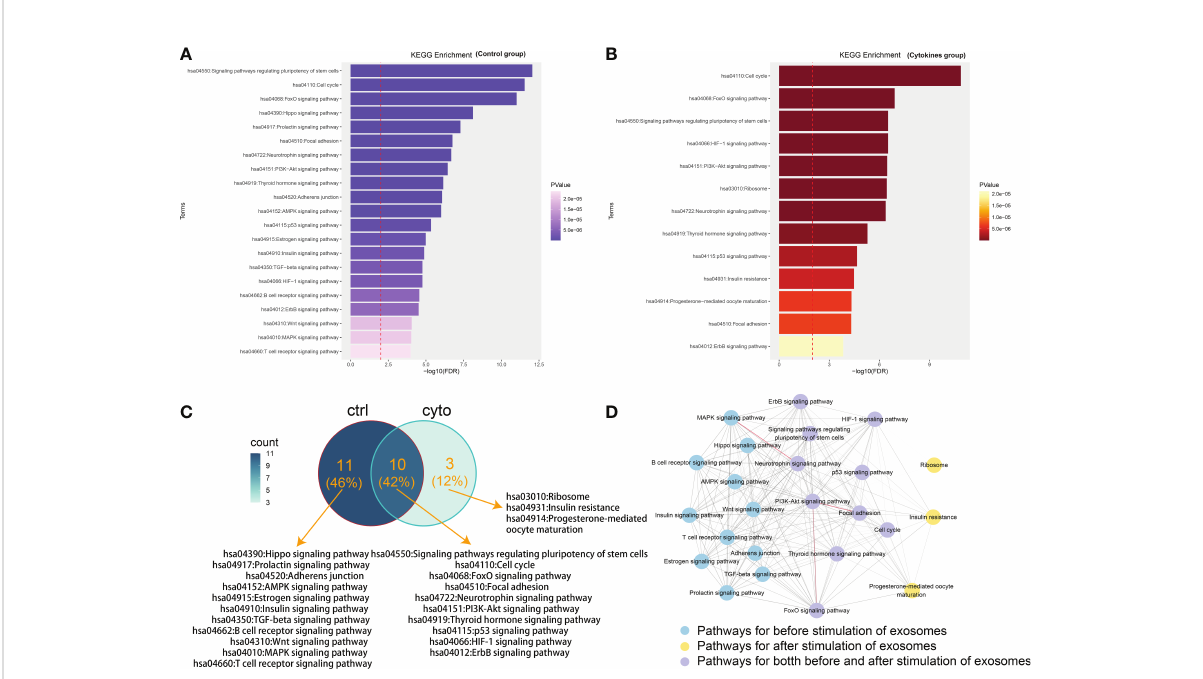
FIGURE 2 Functional analysis of mRNAs in competitive regulatory networks. (A) Gene enrichment function in lncRNA-mRNA network of in control group (without 50 U/ml IL-1 b and 1000 U/ml IFN- g stimulation). (B) Gene enrichment function in lncRNA-mRNA network in cytokines group (with 50 U/ml IL-1 b and 1000 U/ml IFN- g stimulation). (C) Functional comparison of mRNA enrichment in ceRNA network under exosomes of different states. ctrl: Function enriched for mRNAs in network without cytokines stimulation; cyto: Function enriched for mRNAs in network with cytokines stimulation. (D) The pathway crosstalk network. In the crosstalk network, two pathways are connected by an edge if they shared at least one gene. The thickness of the edge is proportional to the number of shared genes between the two connected pathways. Edges colored with red represent the number of shared genes> 20 between the connected two pathways. Pathways with blue, purple and yellow color are speci fi c for different treatment,